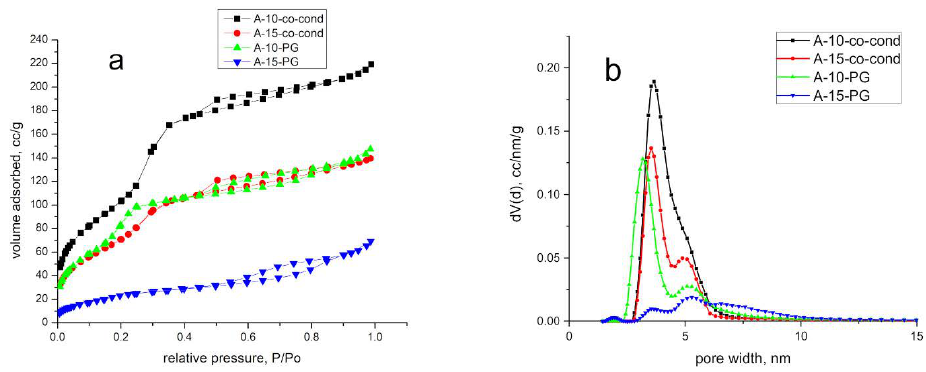
Figure 2. N 2 adsorption-desorption isotherms ( a ) and pore size distributions obtained by DFT ( b ) method of the functionalized mesoporous silica samples.